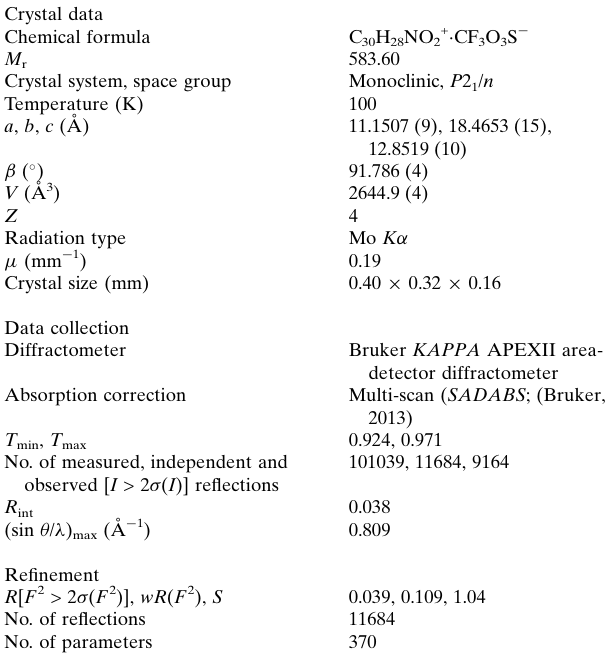
Table 4 Experimental details. Crystal data Chemical